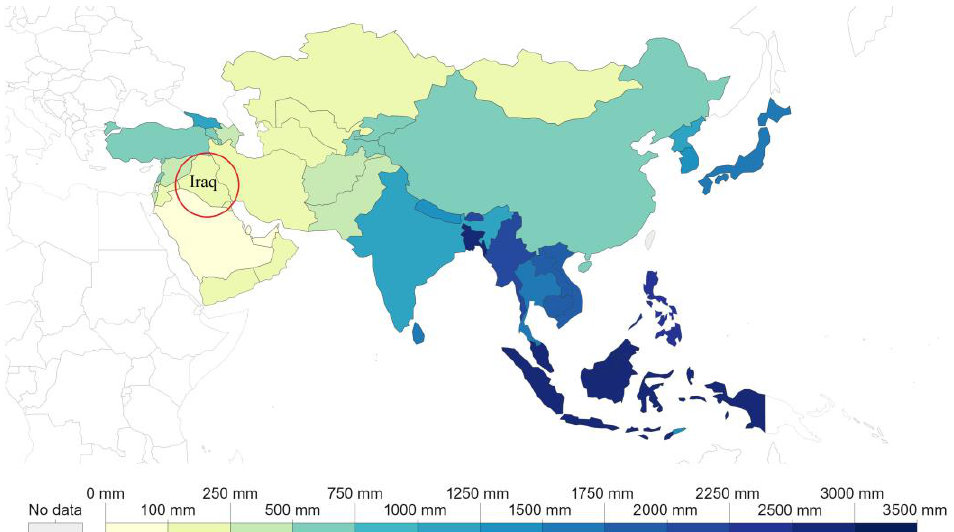
Figure 5. Average annual precipitation (mm/year) in Asia, including Iraq (sourced from the FAO of the United Nations via the World Bank); [41].